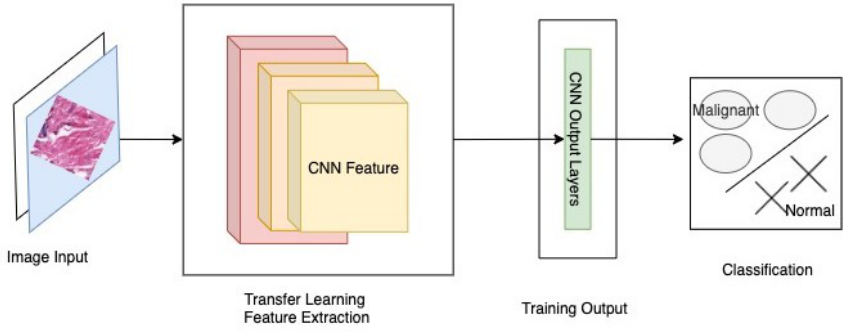
Figure 1. ABCanDroid model